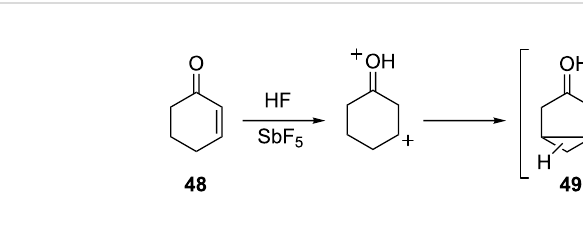
Scheme 10: Reaction of camphor ( 44 ) in superacid.